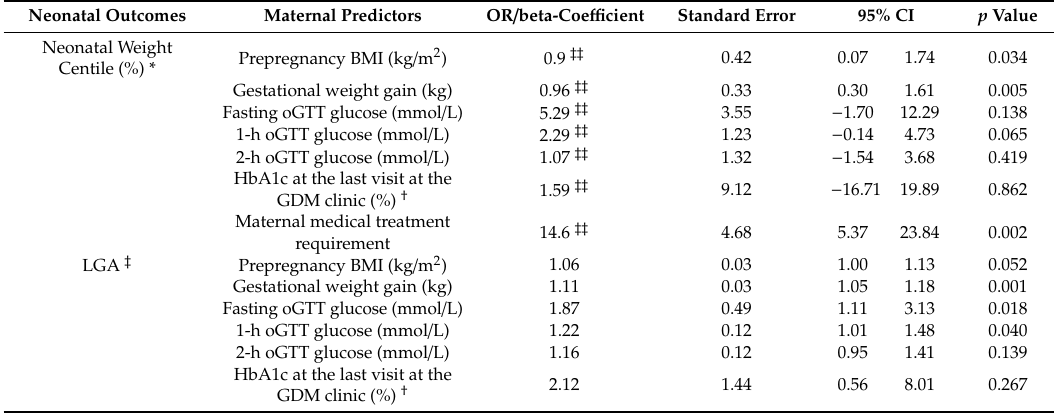
Table A1. Maternal predictors of adverse neonatal